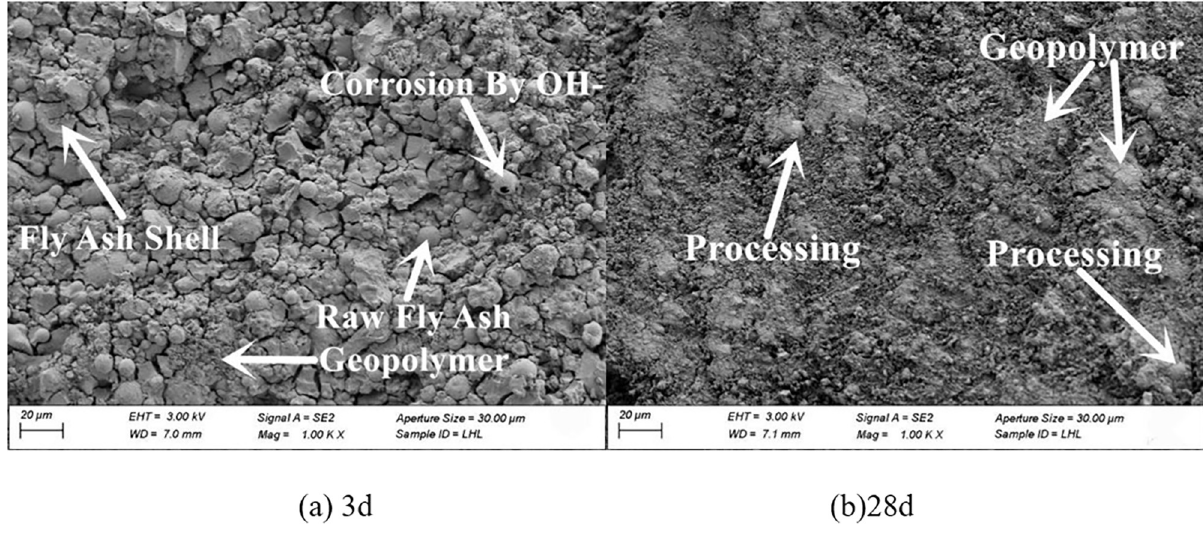
Fig 14. Microscopy analysis of FG3 at 28